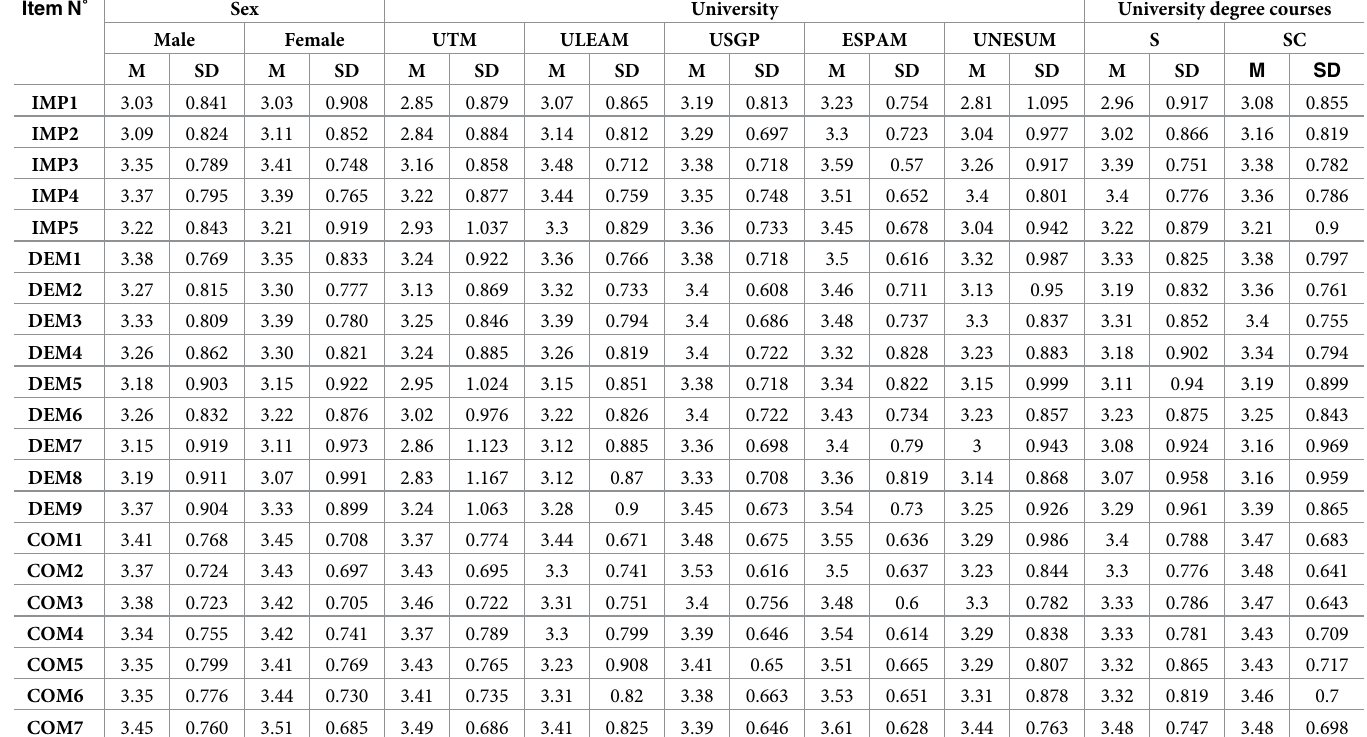
Table 3. Differences in the scale items for university tutoring based by sex, university, and university degree course.